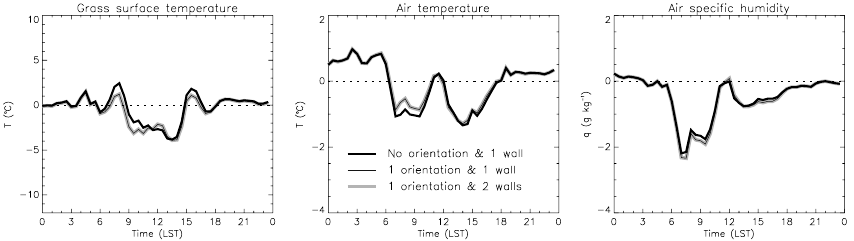
Fig. 8. Temporal evolution of biases (Model-Obs) in grass surface temperature, in air temperature and specific humidity for the Exposed- Grass experiment simulated with the three methods of radiation calculation (same as Fig.